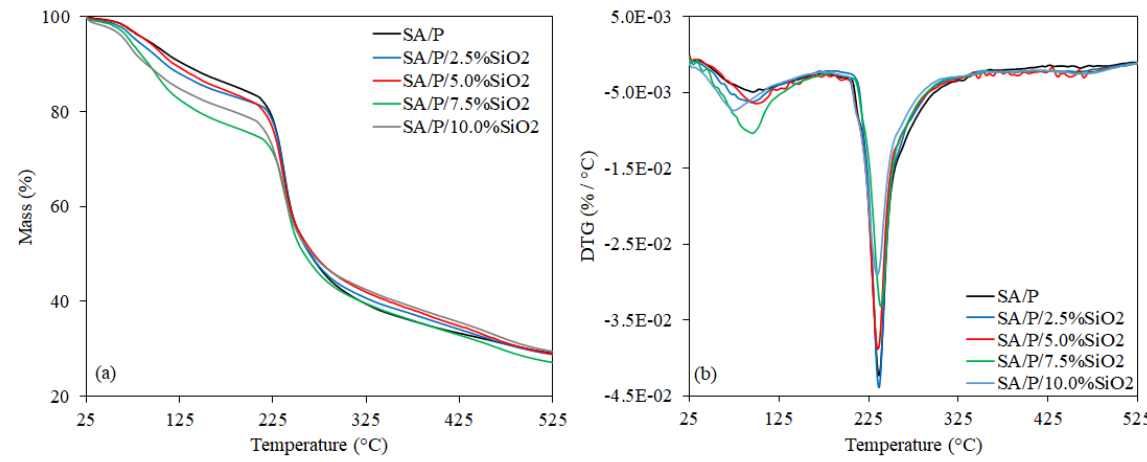
Figure 4. TGA ( a ) and DTG ( b ) of SA/P and SA/P/SiO 2 films.